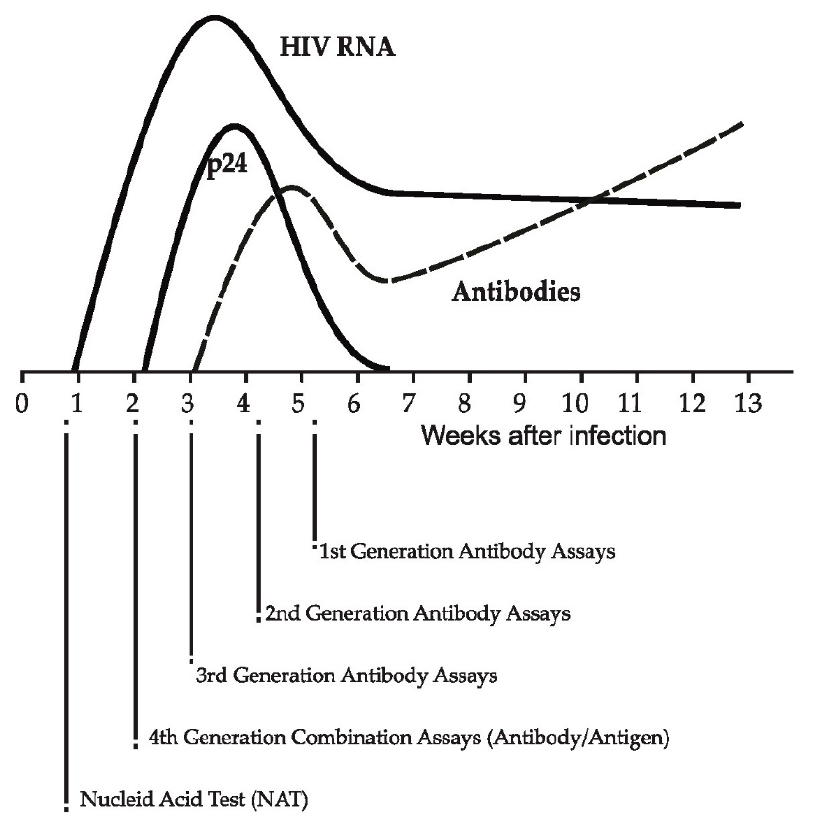
Figure 1. Viral and serological markers during recent HIV infection and evolution of HIV diagnostic assays (adapted from [57]).